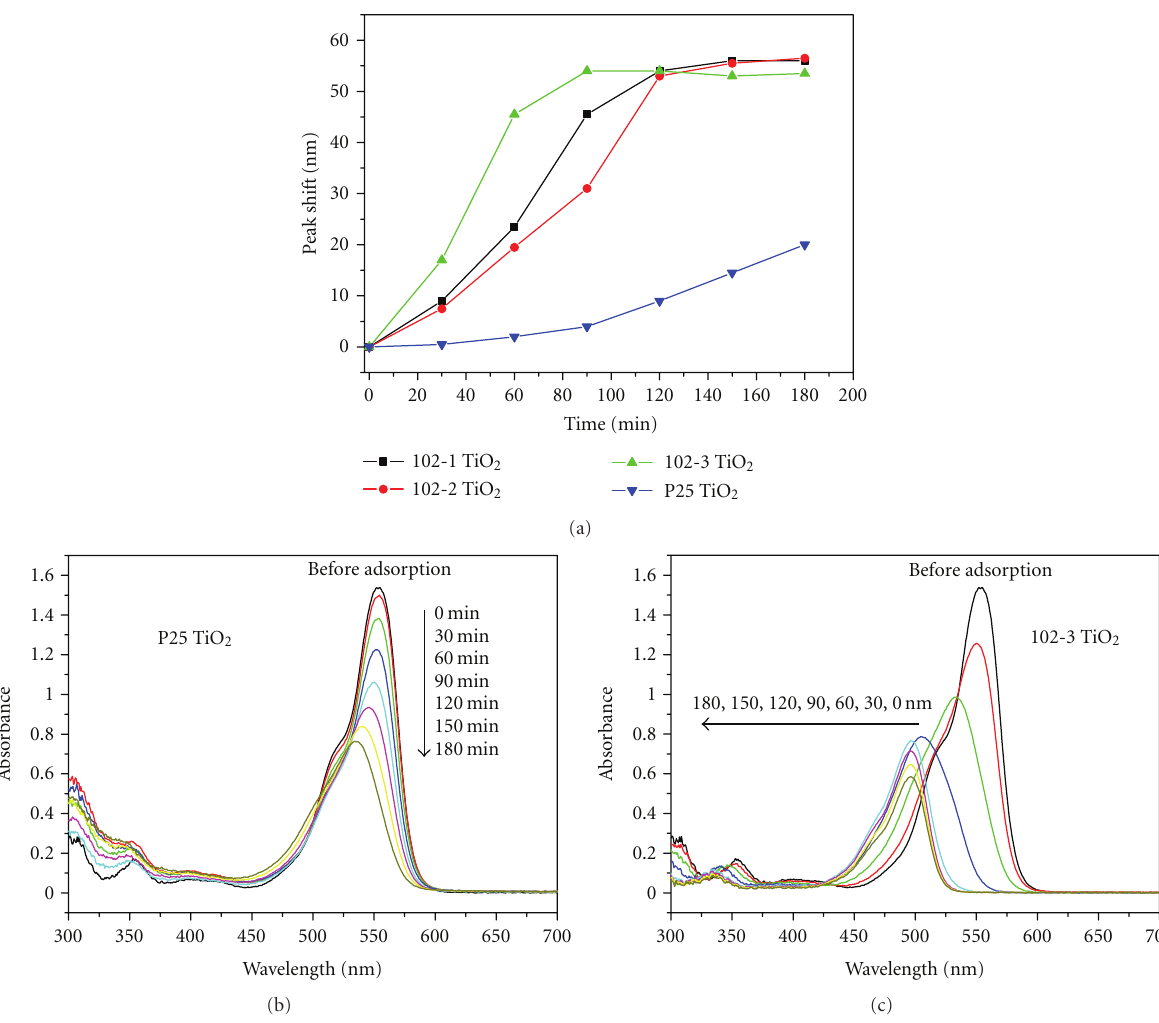
Figure 6: (a) Hypsochromic shifts of the major absorption band of RhB with irradiation time. (b) Gradual spectral changes of RhB in aqueous P25 TiO 2 dispersion under visible light irradiation. (c) Gradual spectral changes of RhB in aqueous 102-3 TiO 2 dispersion under visible light